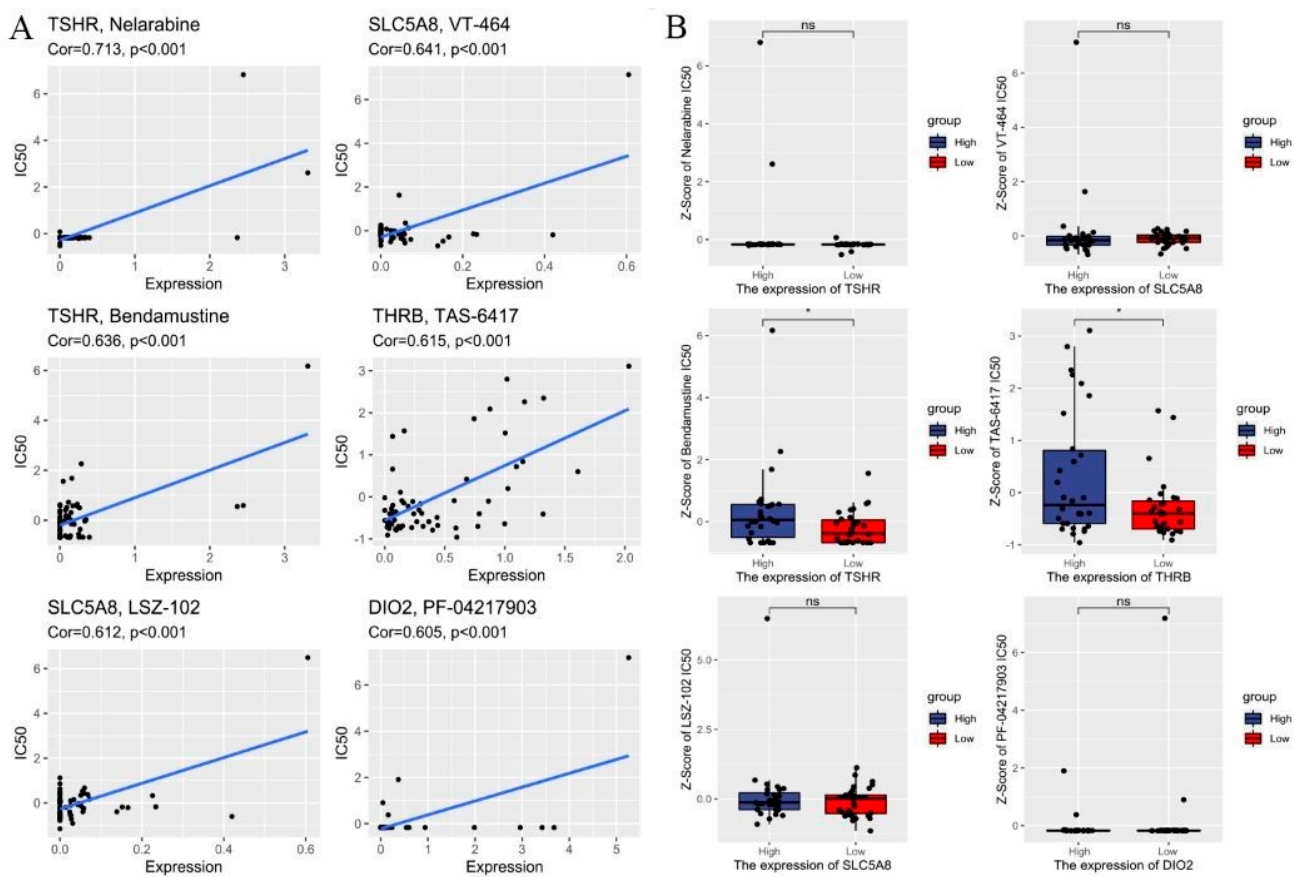
Figure 5. Drug sensitivity analysis. ( A ) Correlations between IC50 for different drugs and differentiation ‐ related regulators. ( B ) Compared the efficiency of the chosen drugs in relation to the risk score. * p < 0.05 and ns: no significance.